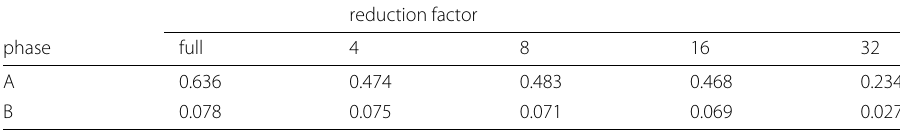
Table 2 Values of the F1 score for the threshold analysis reduction factor phase full 4 8